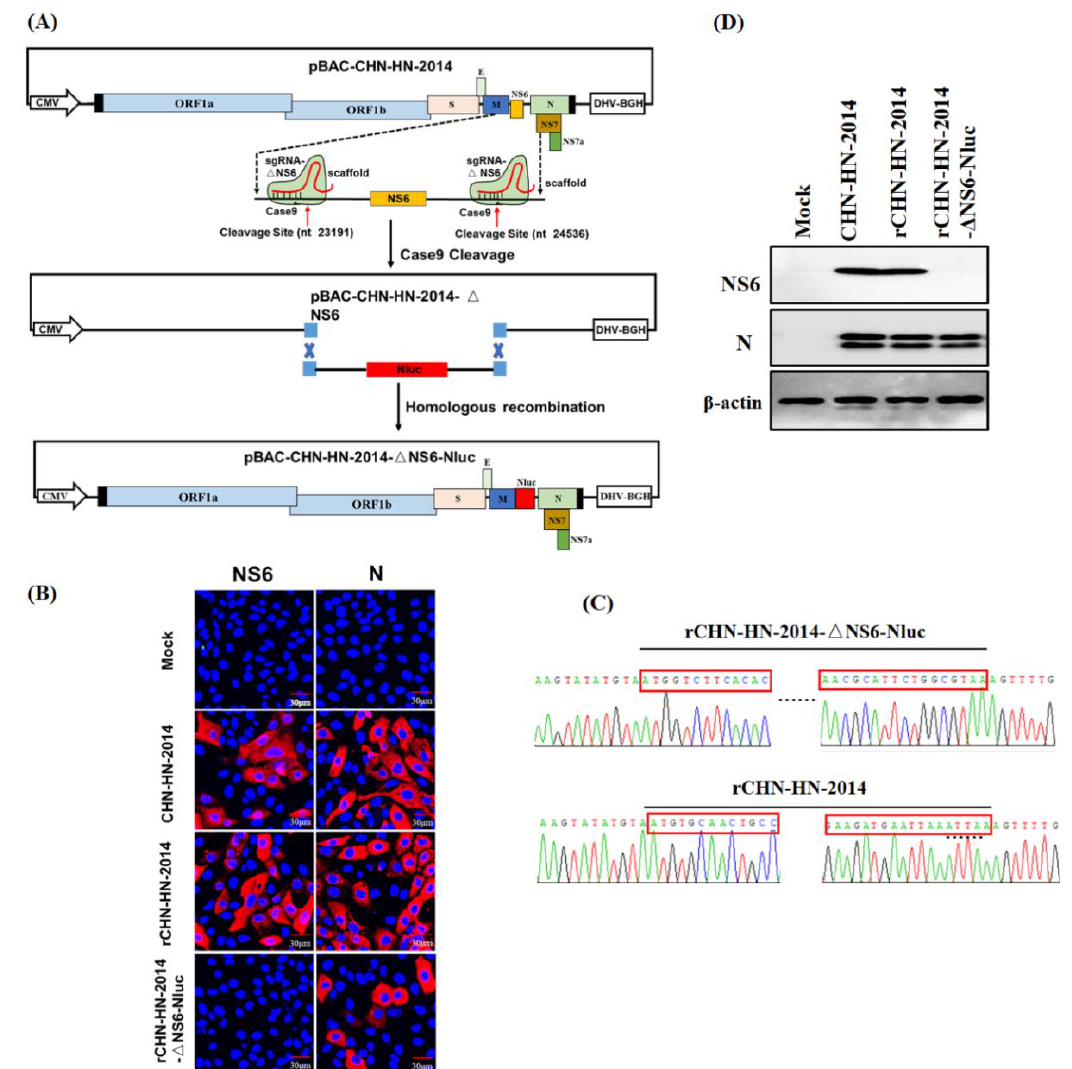
Figure 4. Identification of the rescued PDCoV reporter virus expressing Nluc. ( A ) Schematic diagram of recombinant PDCoV cDNA clone with the replacement of NS6 to Nluc. ( B ) Indirect immunofluorescence analysis of LLC-PK1 cells infected with CHN-HN-2014, rCHN-HN-2014, rCHN-HN-2014- ΔNS6 -Nluc at 12 hpi using anti-PDCoV N or NS6 MAbs. ( C ) Mutation identification by sequencing genome of rCHN-HN-2014- Δ NS6-Nluc and rCHN-HN-2014. The red frames represent the partial N-terminal and C-terminal sequences of Nluc or NS6 gene, respectively. ( D ) Western blot assay for lysates from LLC-PK1 cells respectively infected with CHN-HN-2014, rCHN-HN-2014 and rCHN-HN-2014- ΔNS6 -Nluc at 12 hpi using anti- PDCoV N and NS6 MAbs. β -actin served as a protein loading control. 3.4. Characterization of Growth Kinetics of Nluc Reporter Virus In Vitro To examine the Nluc expression kinetics in vitro, LLC-PK1 cells were inoculated with Nluc reporter virus, and then were harvested to detect the Nluc signals. As shown in Fig- ure 5A, Nluc signals measured at each time point of infection gradually and time-de- pendently increased, similar to the kinetics of N protein expression in cells infected with Nluc reporter virus. At 3 hpi, an obviously increased luciferase signals were detected com- pared to the mock-infected control group, although at this time point, the N protein level was barely detected by Western blot. These results showed that the increase in Nluc sig- nals expression was notably correlated with viral proliferation in Nluc reporter virus-in- fected cells and further demonstrated the high sensitivity of Nluc for reflecting viral rep- lication than N protein expression, especially at the early stage of viral infection. We fur- ther examined the growth kinetics of Nluc reporter virus in vitro and found that all